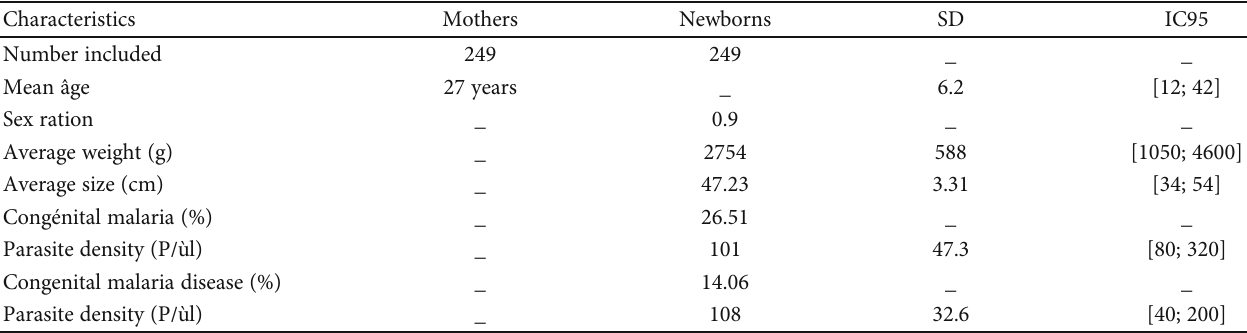
Table 1: Characteristics of the population.